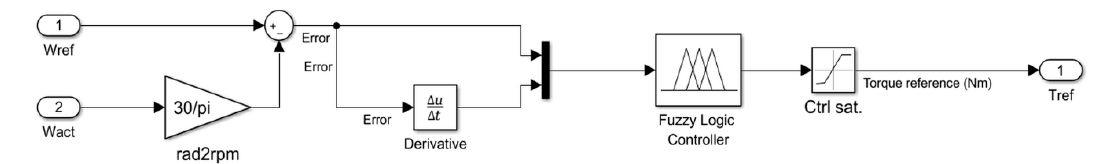
Figure 6. Fuzzy logic controller in MATLAB / Simulink. Table 4. Rule Table for fuzzy logic controller.